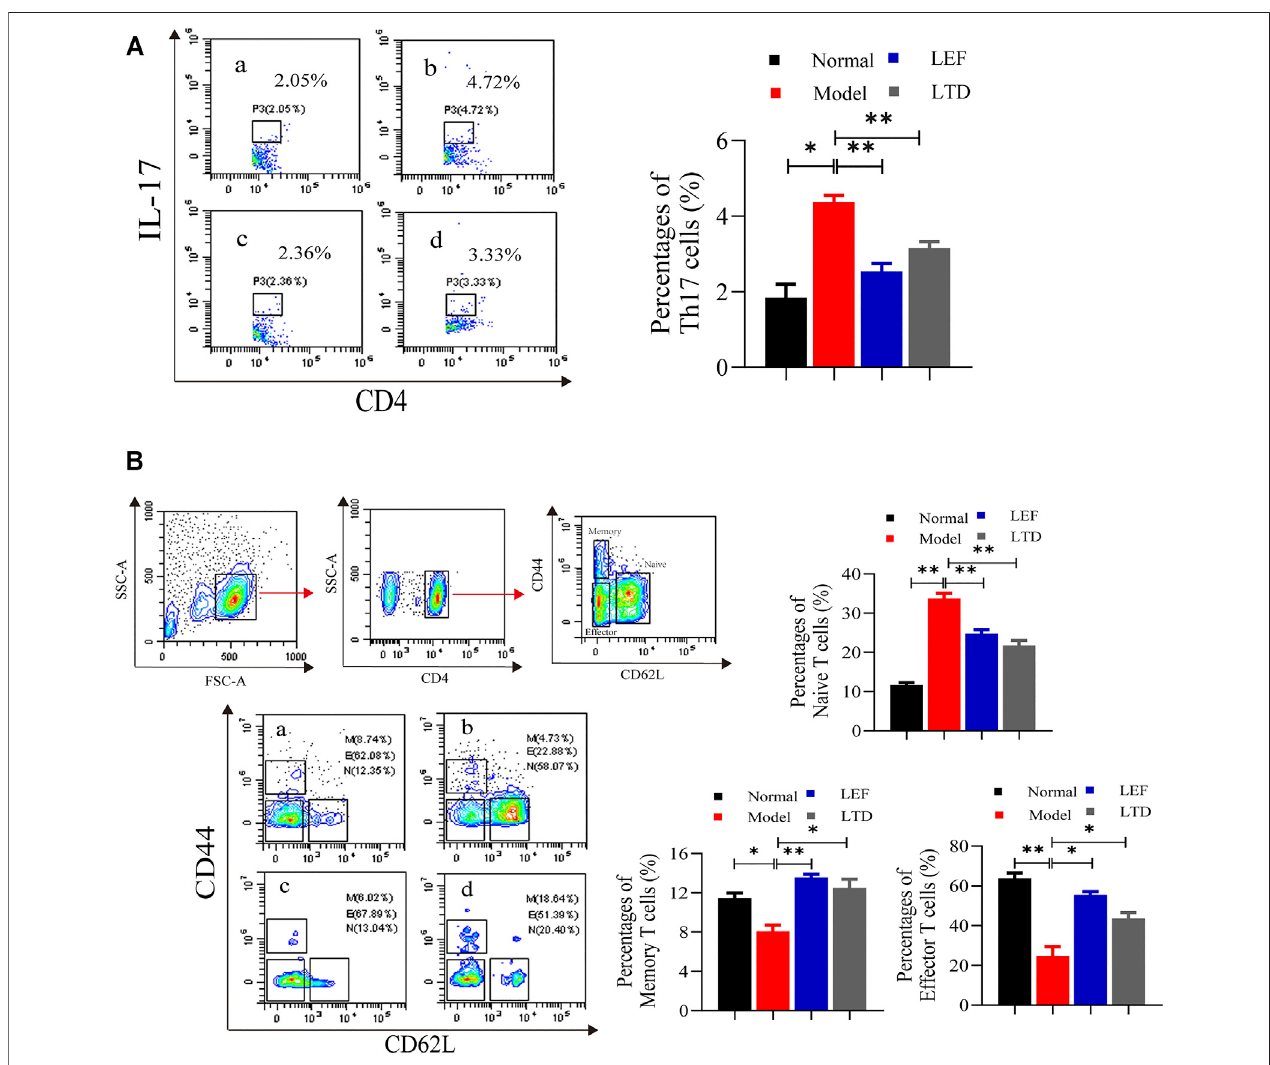
FIGURE4| ThepercentagesofTh17,MemoryTcells,NaiveTcells,andEffectorTcells. (A) AscatterplotofrepresentativeTh17cells; (B) Atypicalcontourmapof Memory Tcells, Naive Tcells, and Effector T cells. The results are presented inthe bar charts ( n (cid:1) 3). a: normal group, b:model group, c:LEF group, d:LTD group. Data are presented as the means ± S.D.* p < 0.05,** p <